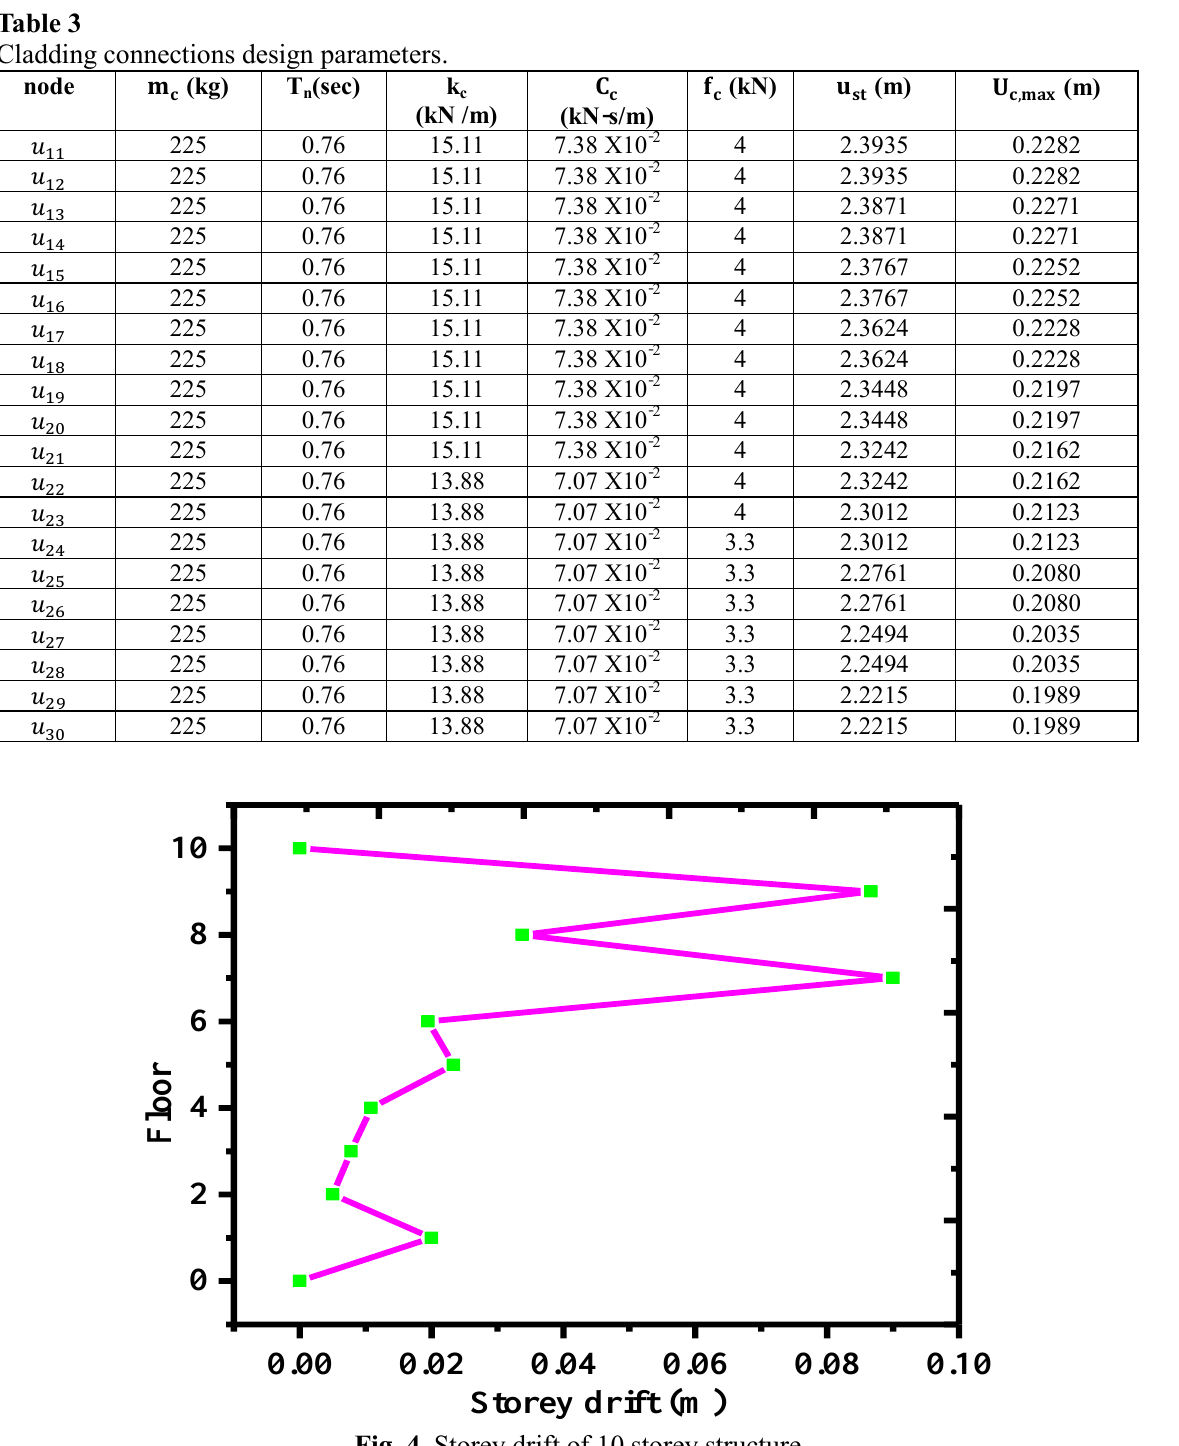
Fig. 4. Storey drift of 10 storey